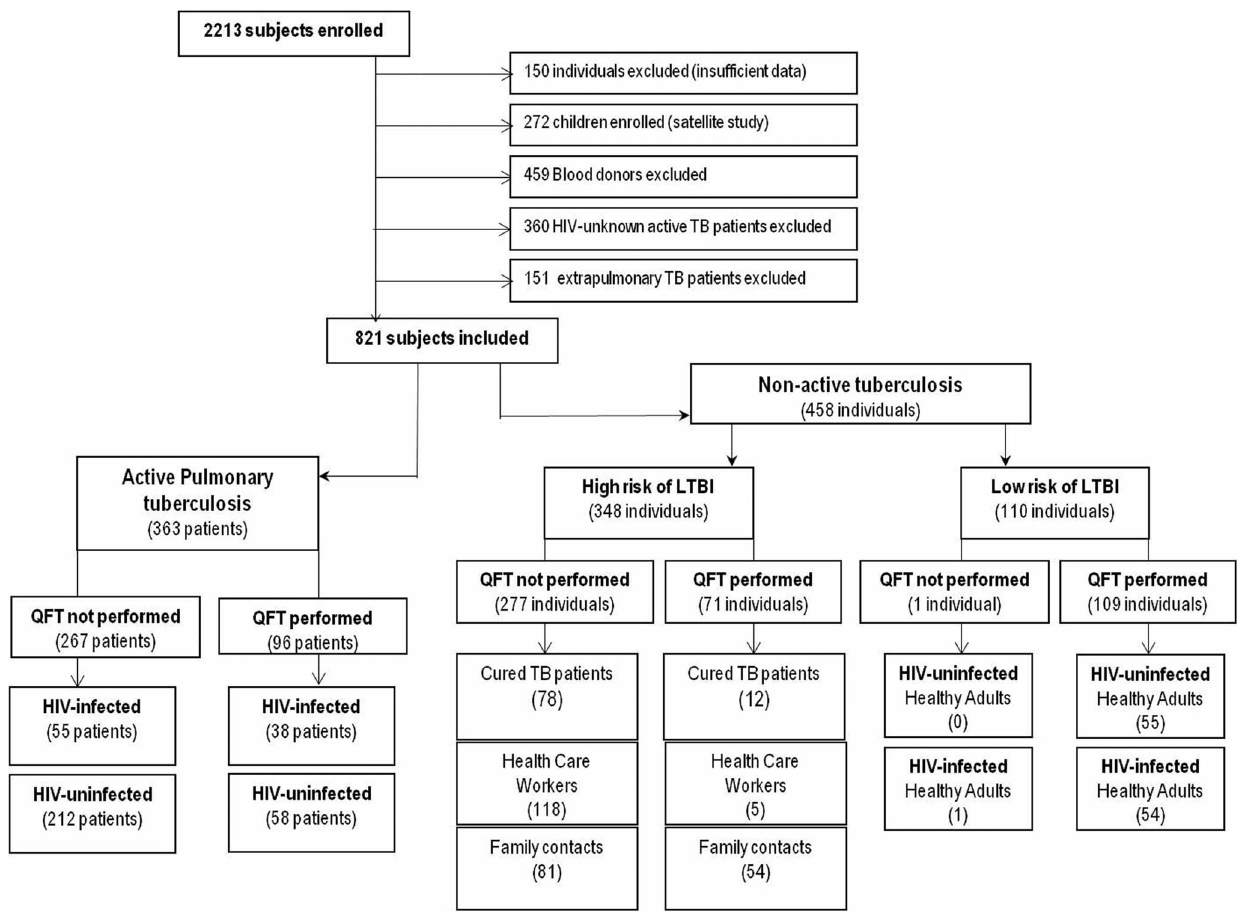
Figure 1. Flow chart of patients recruited to the multicentric study stratified by patient subgroups. Abbreviations: TB: tuberculosis; HIV: human immunodeficiency virus; LTBI: latent tuberculosis infection.